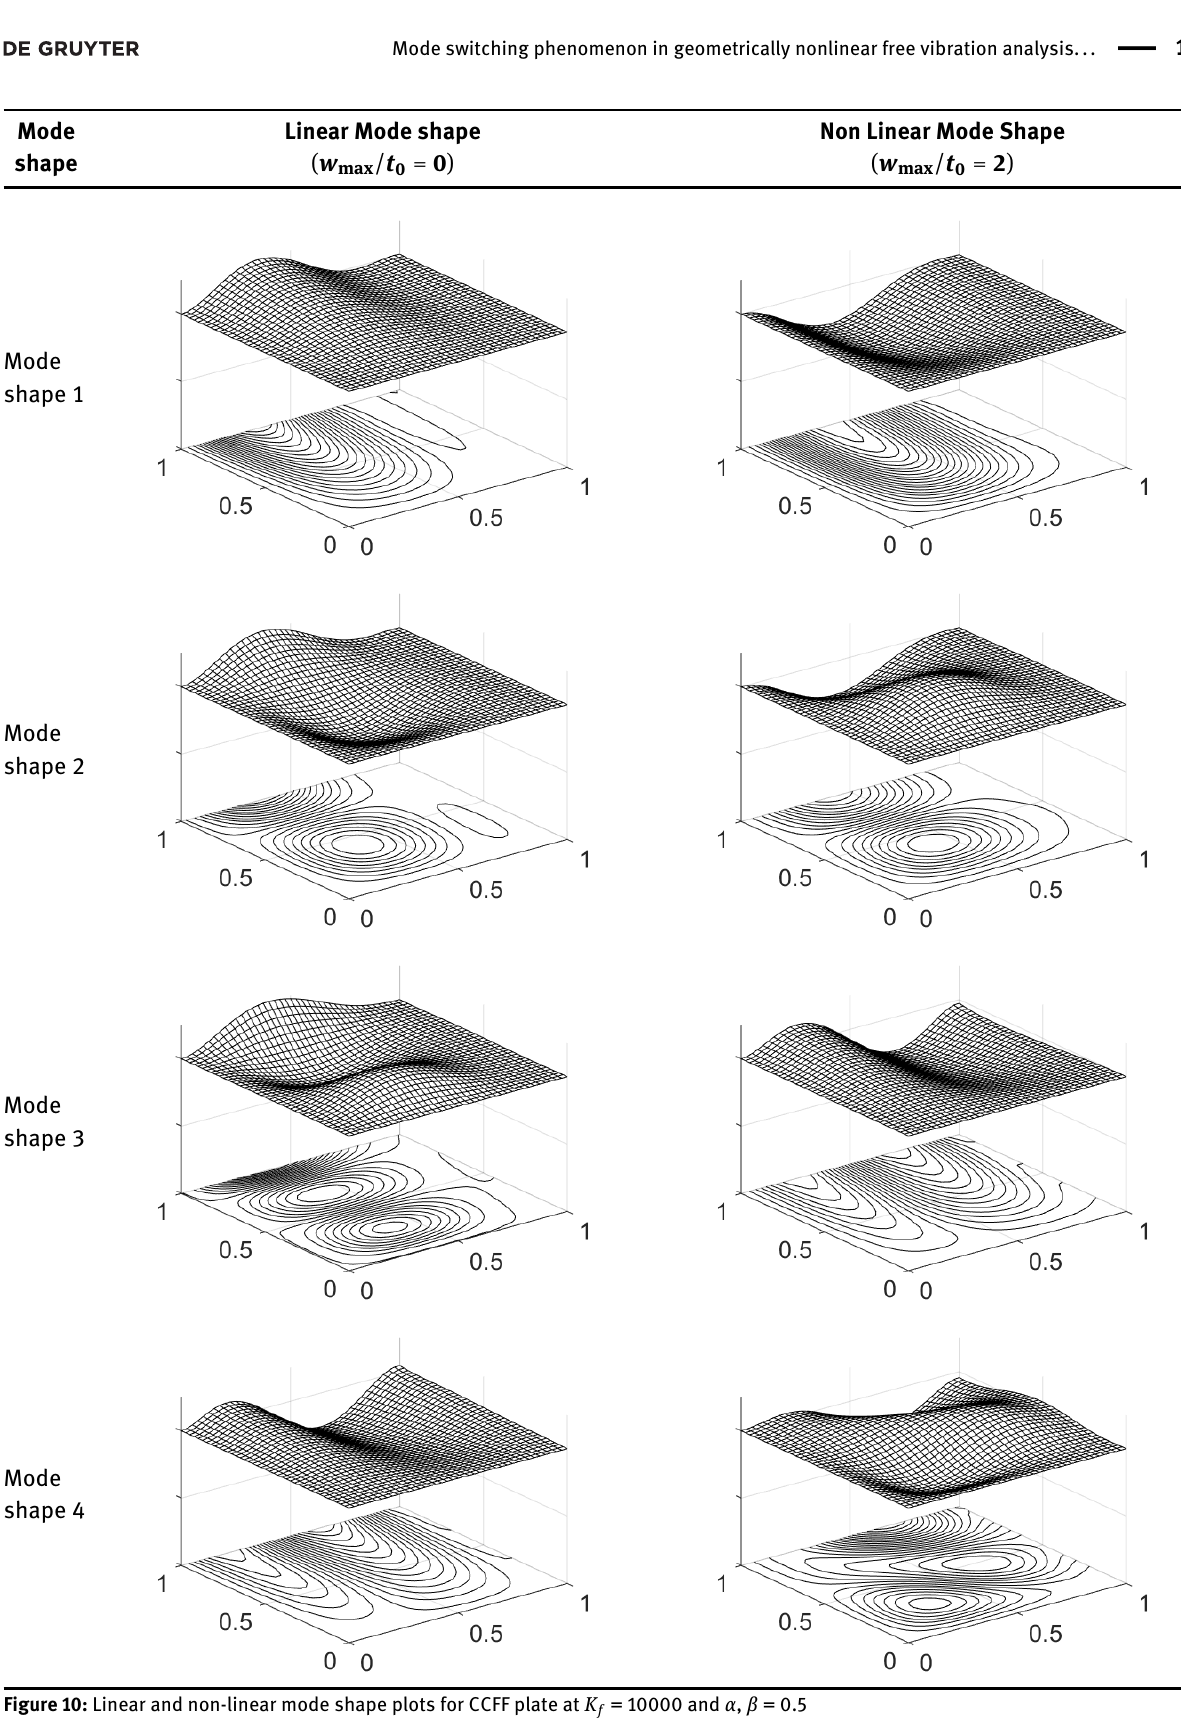
Figure 10: Linear and non-linear mode shape plots for CCFF plate at K f = 10000 and α , β =